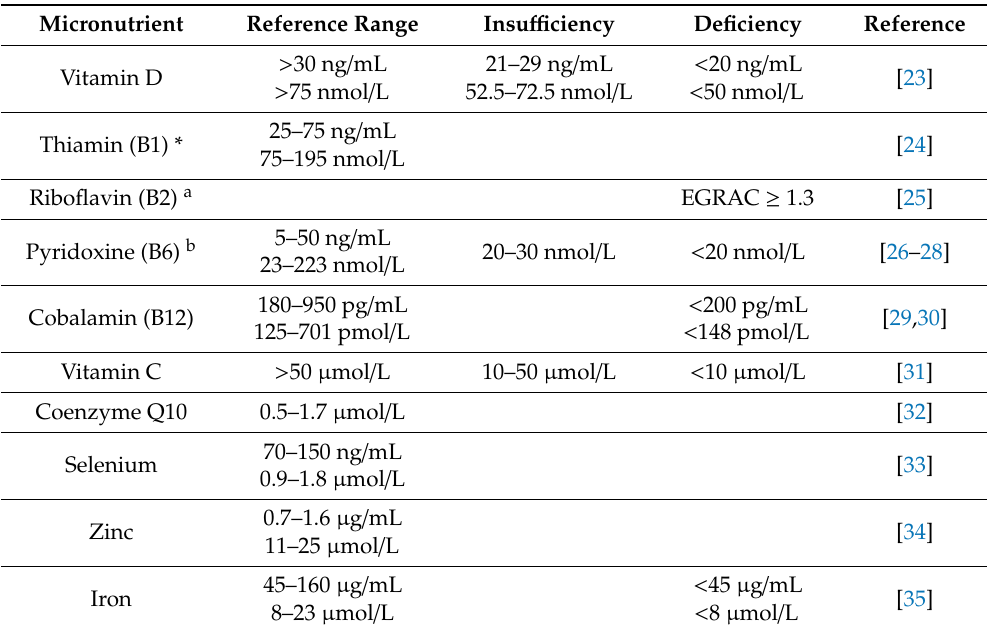
Table 2. Serum normal concentrations and definition of deficiency of